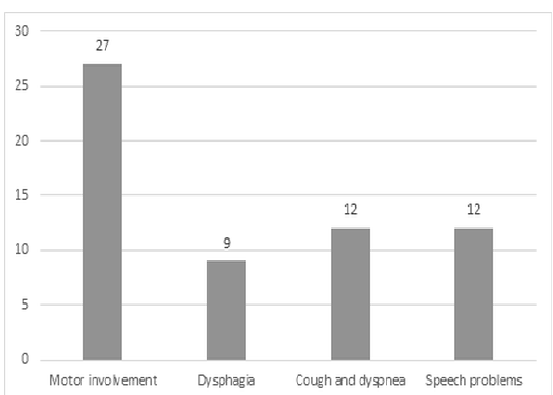
Figure 1. Frequency of symptoms among the study